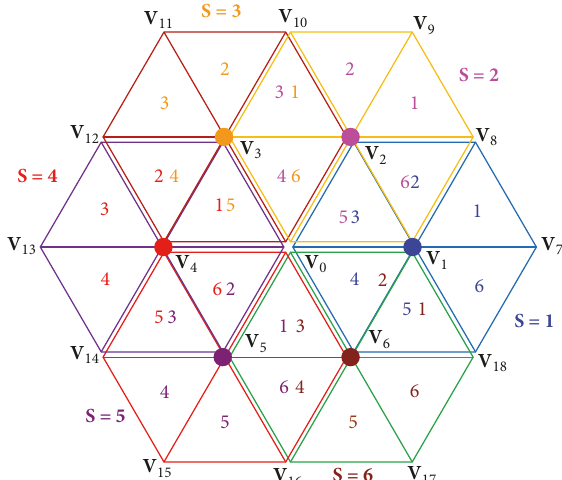
Figure 3: Diagram of transforming between three-level space vector to two-level space vector.